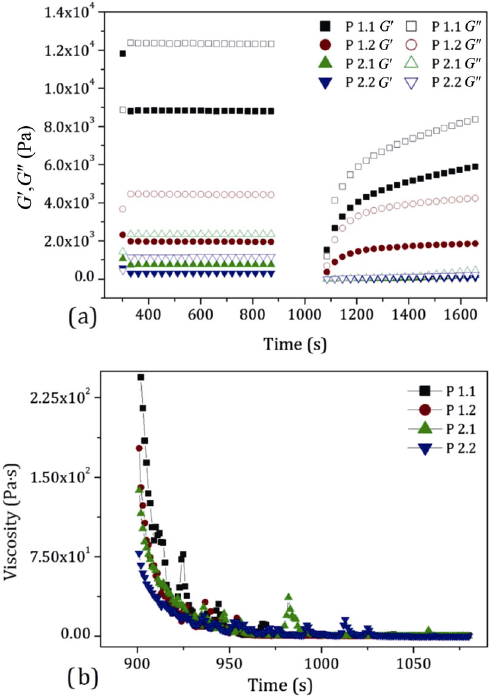
Fig. 4 Topography of green screen printed layers of all paste compositions and pastes P2.1 and P2.2 after 5 h sintering at 1400 ℃ in